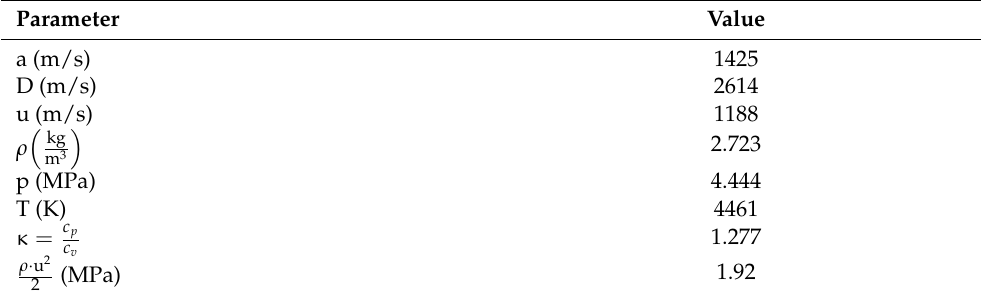
Table 3. Thermo-kinetic parameters of combustion products at the time of detonation in the Chapman– Jouget (C-J) plane determined using the thermodynamic code TIGER.